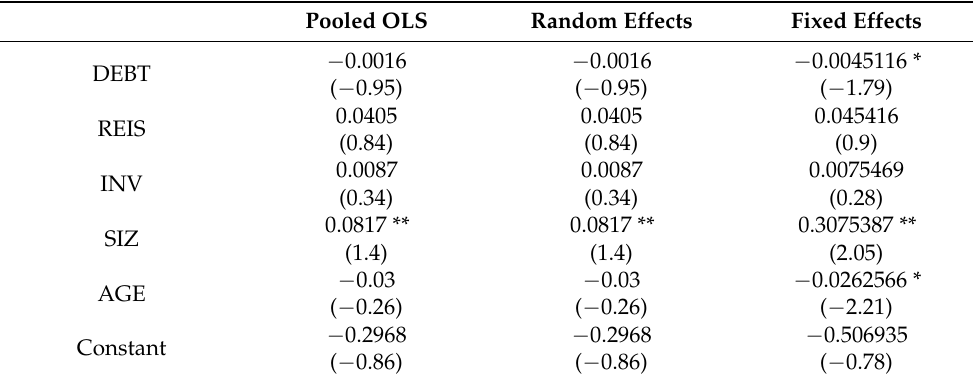
Table 7. Empirical Results When ROE is Used as the Measure in Panel